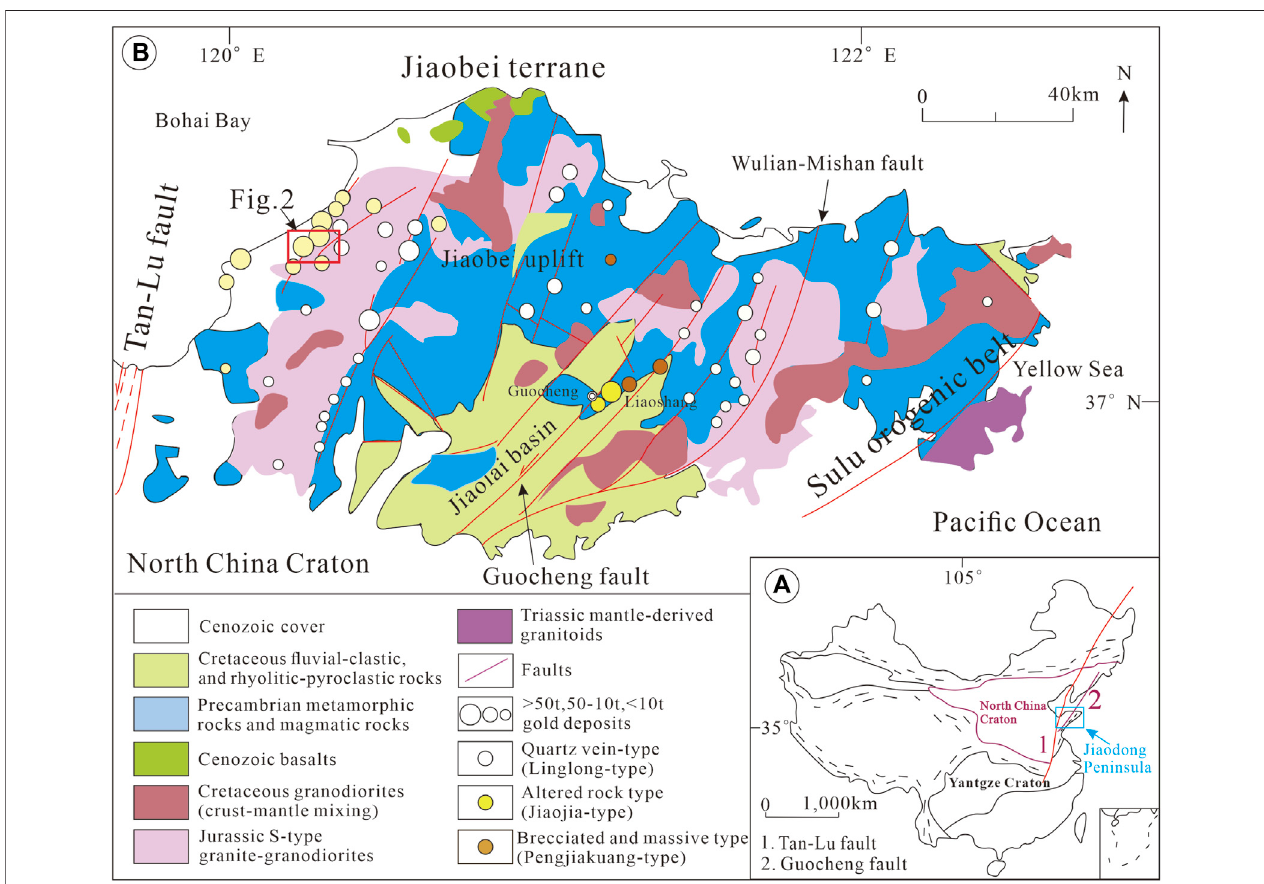
FIGURE 1 | Geologic map of the Jiaodong region (A) , showing the distribution of different types of gold deposits (B) . (after Deng et al., 2015).